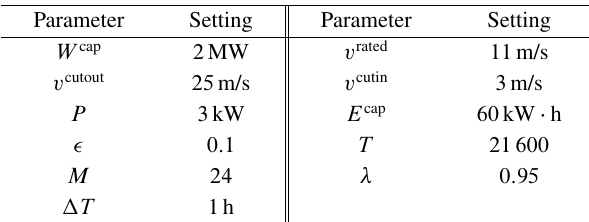
Fig. 3 Flowchart of Algorithm 1. Table 2 Parameter